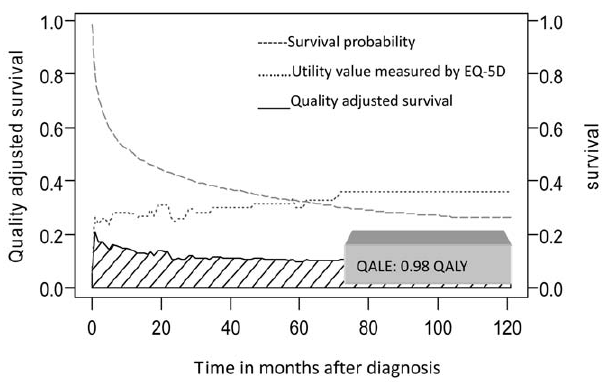
Figure 2. Quality adjusted survival for patients undergoing PMV (prolonged mechanical ventilation) with partial cognition after adjustment for survival function (N=50,481) with the utility values of quality of life measured with EQ-5D (N=55). The result of QALE (quality-adjusted life expectancy) of an average patient was 0.98 QALY by summing the areas under the quality-